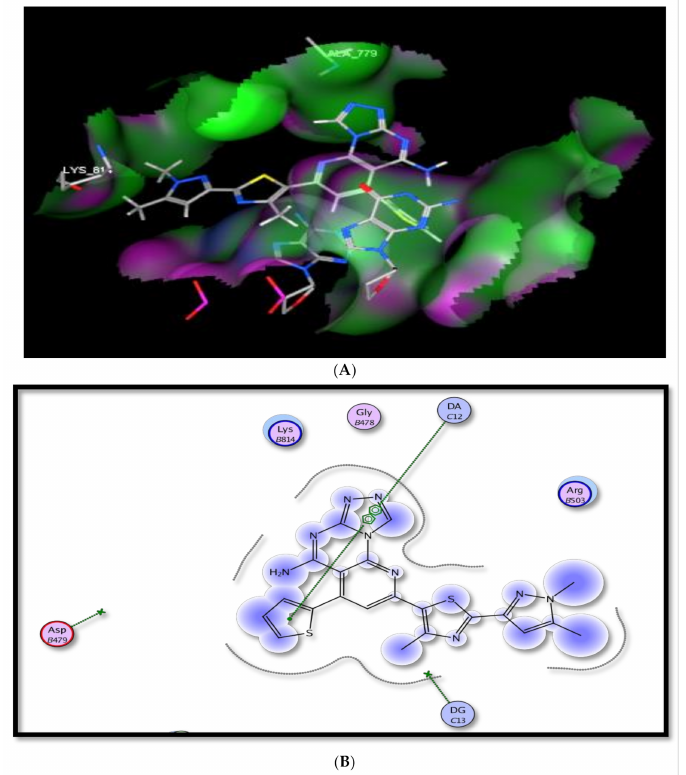
Figure 12. The suggested binding mode of compound 16 within topoisomerase II. ( A ) 3D binding mode within the active site. ( B ) 2D binding mode within topoisomerase